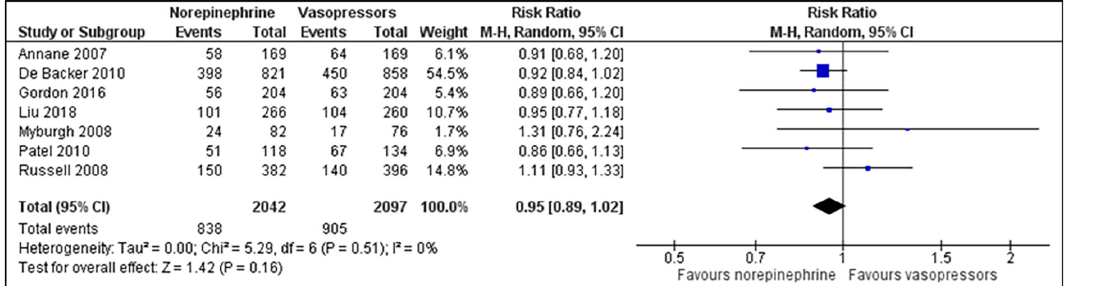
Figure 3. Comparison between norepinephrine and vasopressors for the outcome of the number of participants with all-cause 28- day mortality. M-H, Mantel-Haenszel method; CI, confidence